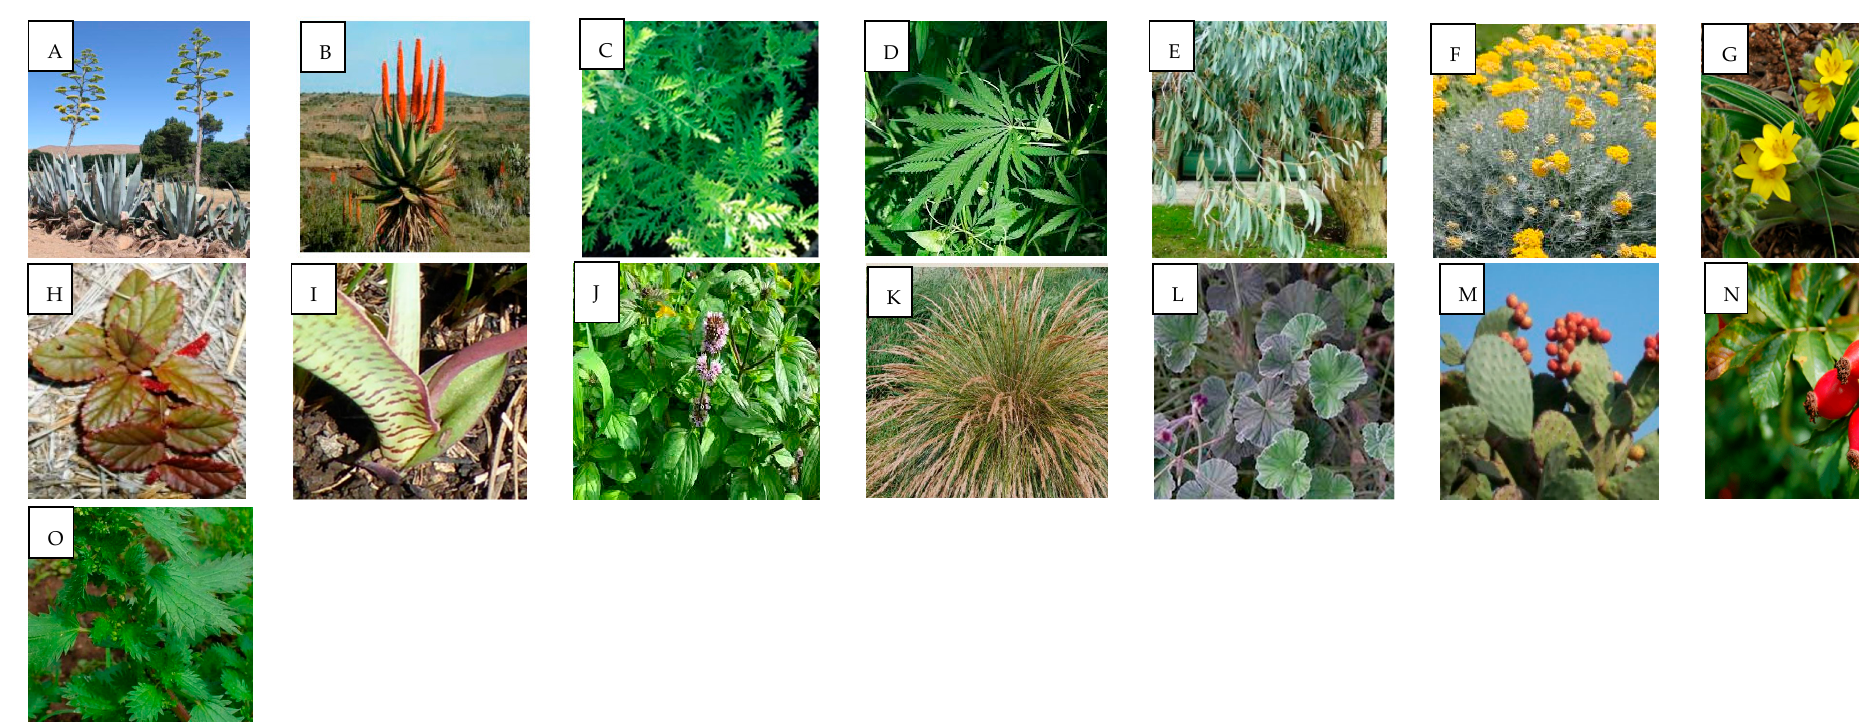
Figure 2. Plants used for development of various commercial products in Lesotho: ( A ) Agave americana , ( B ) Aloe ferox , ( C ) Artemisia afra , ( D ) Cannabis sativa , ( E ) Eucalyptus rubida , ( F ) Helichrysum odoratissimum , ( G ) Hypoxis hemerocallidea , ( H ) Hemannia depressa , ( I ) Ledebouria cooperi , ( J ) Mentha sp., ( K ) Merxmuellera sp., ( L ) Pelargonium sidoides , ( M ) Opuntia ficus-indica , ( N ) Rosa rubigonosa , ( O ) Urtica urens (Source K. Kobisi & L. Seleteng-Kose).